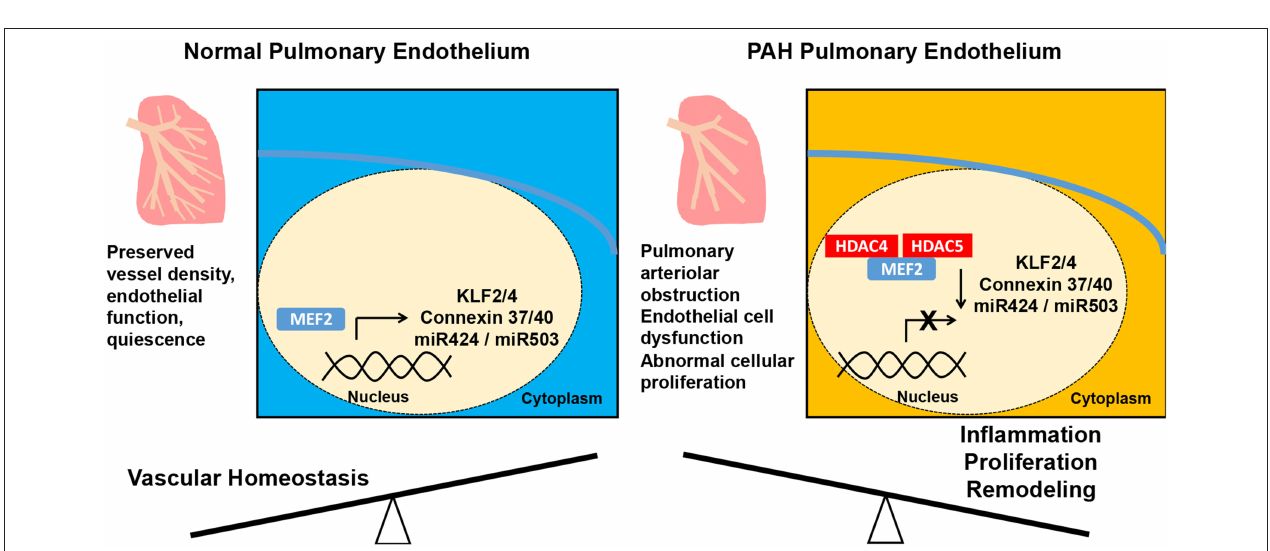
FIGURE 2 | Alteration of the pulmonary vascular endothelium in pulmonary arterial hypertension (PAH). In the normal pulmonary vasculature, MEF2 promotes endothelial function preserving vessel density. In PAH, downregulation of MEF2 from increased nuclear localization of HDAC4 and HDAC5 results in decreased MEF2 activity and decreased expression of antiproliferative miR-424 and miR-503, the vascular homeostatic factors connexins 37, 40, and the anti-inflammatory and antithrombotic KLF2 and KLF4. These molecular alterations then lead to abnormal endothelial cell proliferation and muscularization of the pulmonary arterioles. MEF2, myocyte enhancer factor; HDAC, histone deacetylase; mir, micro ribonucleic acid.